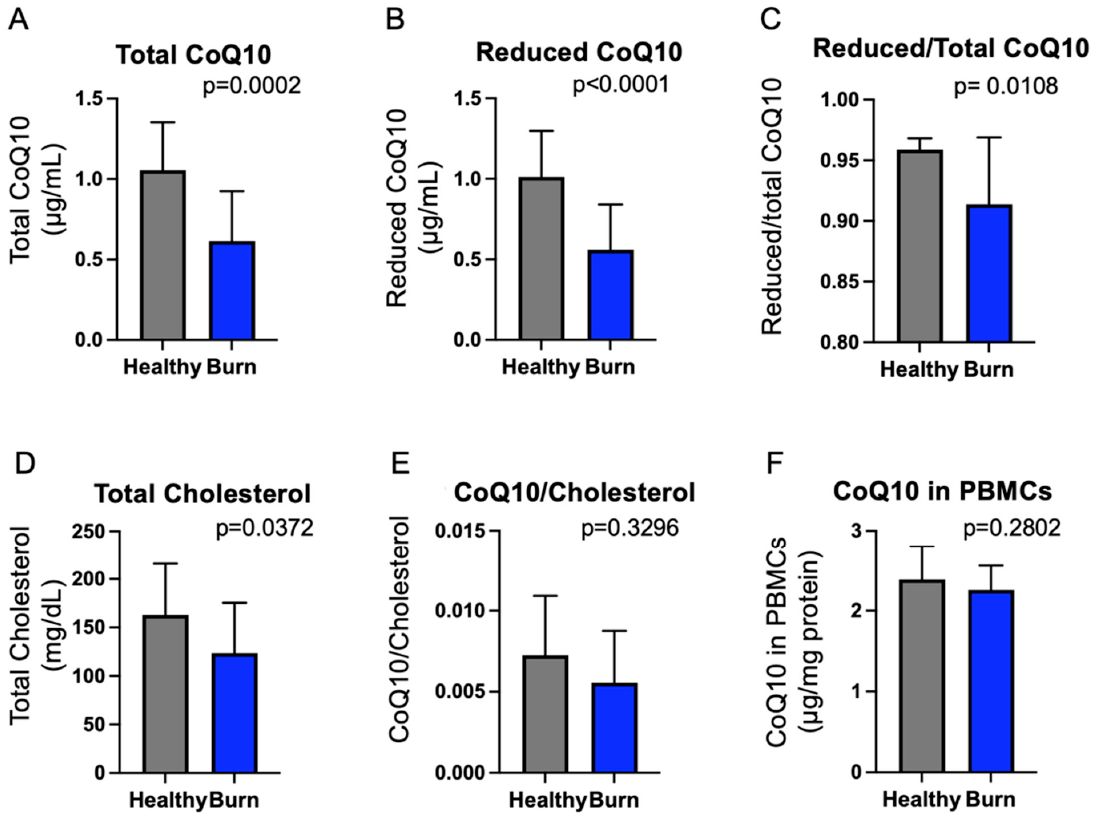
Figure 1. Comparison of basal CoQ10 status between burn patients and healthy volunteers. ( A – D ) Baseline plasma total CoQ10 concentrations ( A ), reduced CoQ10 concentrations ( B ), reduced-to-total CoQ10 ratio (reduced/total CoQ10) ( C ), and total cholesterol levels ( D ) were significantly lower in burn patients ( n = 29) than in healthy volunteers ( n = 11). ( E , F ) There were no statistically significant differences in plasma total CoQ10-to-total cholesterol ratio (CoQ10/cholesterol) ( E ) and baseline total CoQ10 content in PBMCs ( F ) between burn patients and healthy volunteers. Statistical analysis was performed using the unpaired two-tailed Student’s t